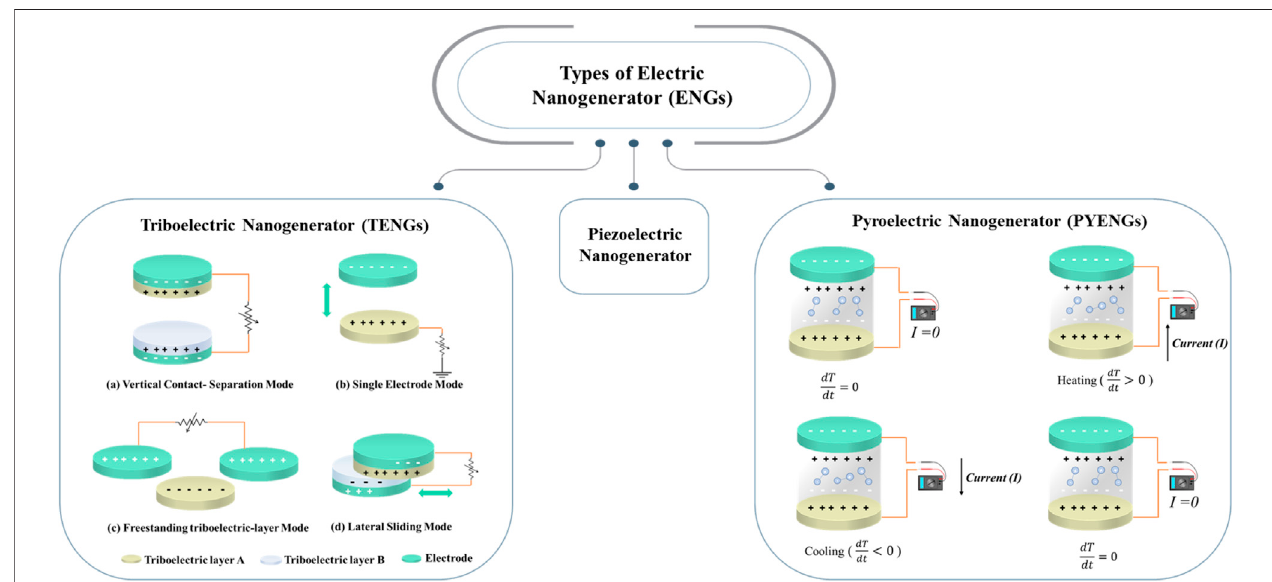
FIGURE 5 | Illustrates the types of nanogenerators: Triboelectric (TENGs), Piezoelectric, and Pyroelectric (PYENGs) nanogenerators. Left schematic diagrams show TENGs operation modes. While right schematic diagram illustrates the working mechanism of PYENGs. In TENGs operation modes. (A) : vertical contact separation mode, (B) : freestanding triboelectric layer mode, (C) : single electrode